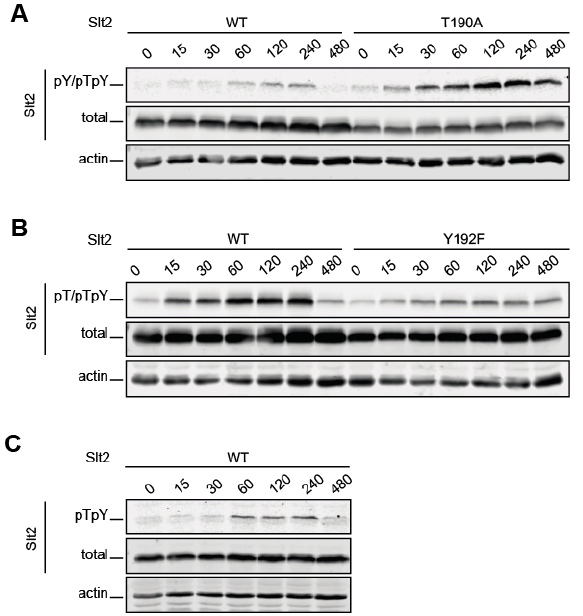
Figure 2. Analysis of Slt2 phosphorylation dynamics. BY4741 slt2 Δ -RLM1Myc cells containing the plasmid pRS316 expressing, as indicated, Slt2 (WT), Slt2 T190A , or Slt2 Y192F , were grown to the mid-exponential phase in YPD and then stimulated with 30 µg/mL of Congo Red for the indicated times (min). Cell extracts were resolved by SDS–PAGE , and analyzed by immunoblotting with anti-Slt2-pY/pTpY ( A ), anti-Slt2-pT/pTpY ( B ), and anti-Slt2-pTpY ( C ), as in Figure 1; anti-Mpk1 , which detects the total Slt2; and anti-actin antibodies ( A – C ). A representative assay from three different experiments with distinct transformants is shown.